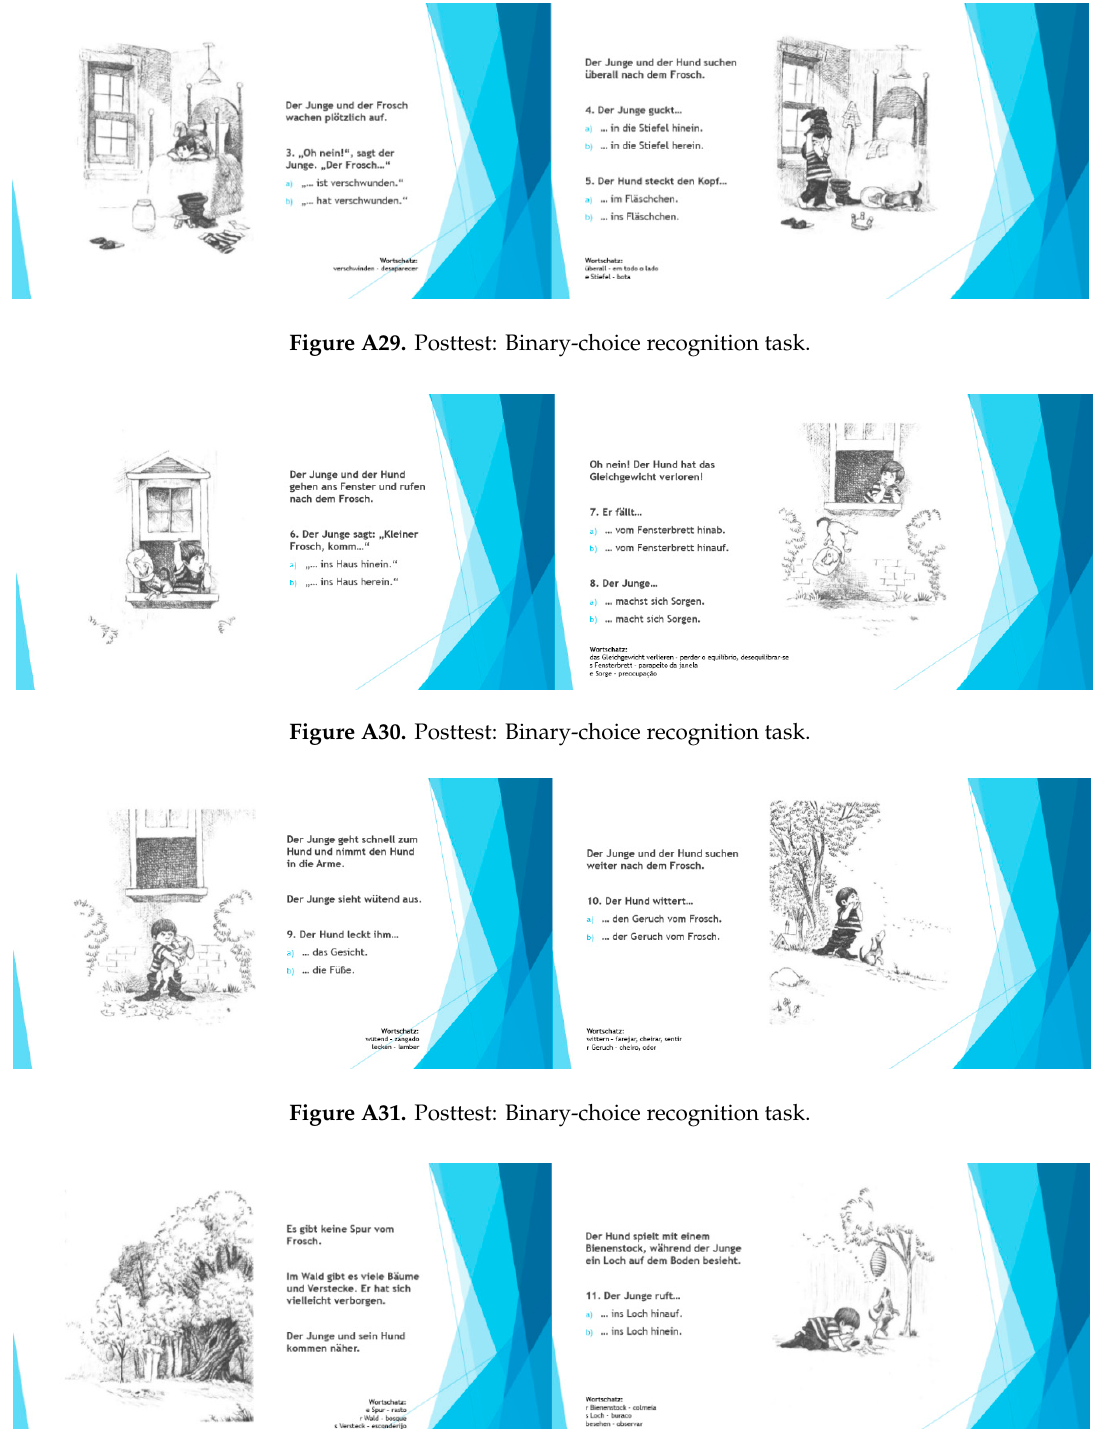
Figure A32. Posttest: Binary-choice recognition task.